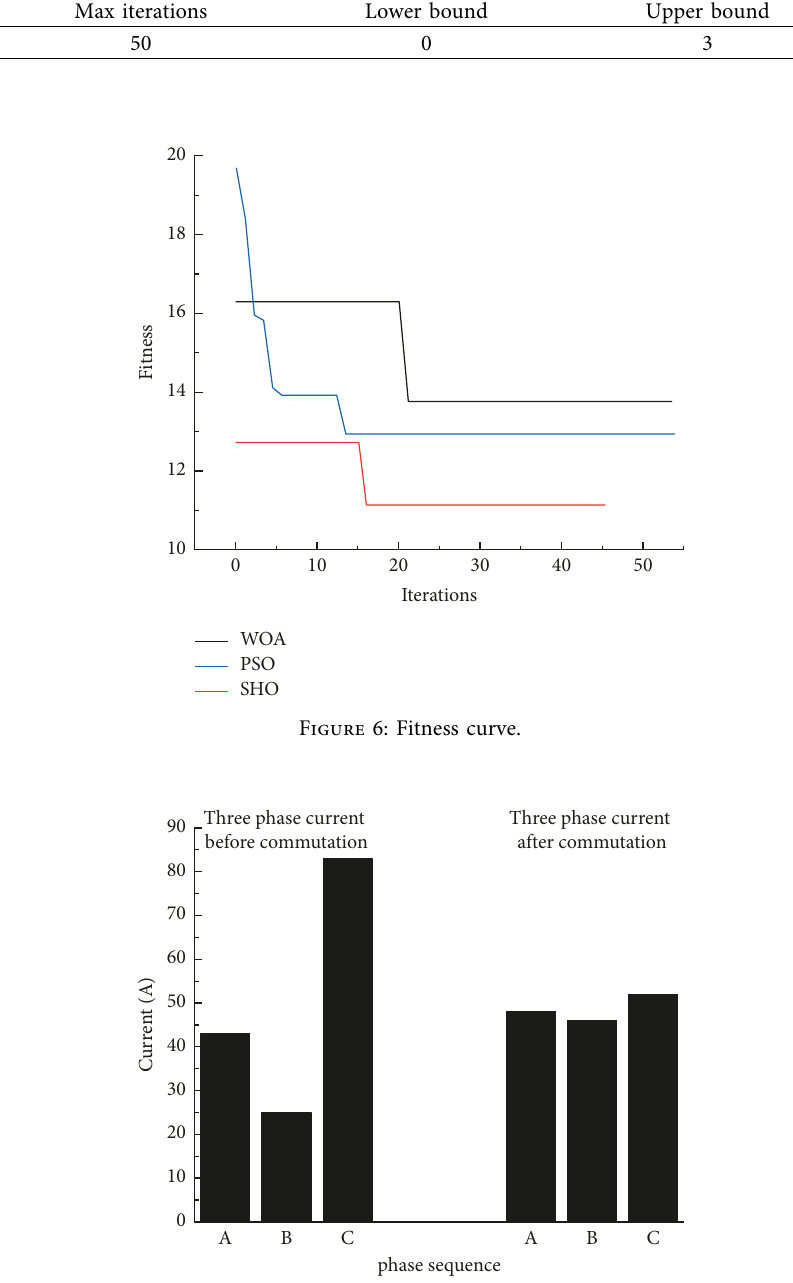
Figure 7: Current comparison. Table 3: Current value after